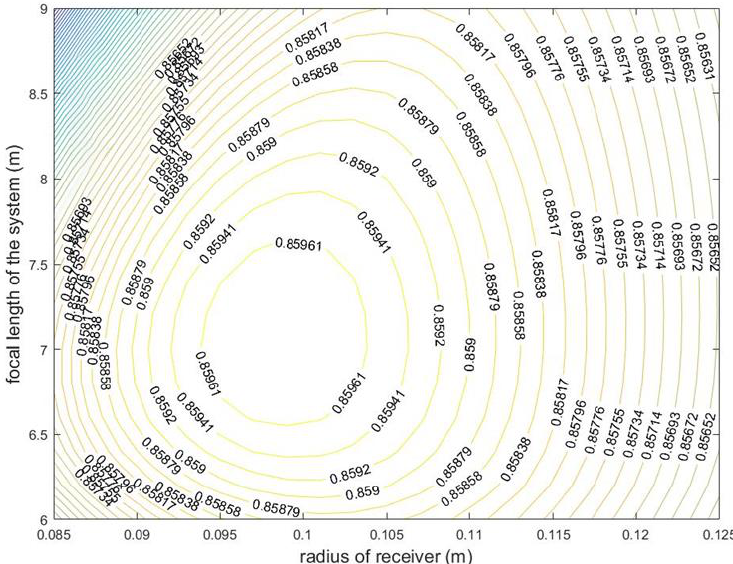
Figure 9. Variation of the net thermal efficiency with receiver radius r and system focal length f for a multi-dish collector; loss rate = 1.67 × 10 3 W/m 2 , absorptivity = 0.98, CSR = 0.05, optical error = 2 mrad, and f x = f p.